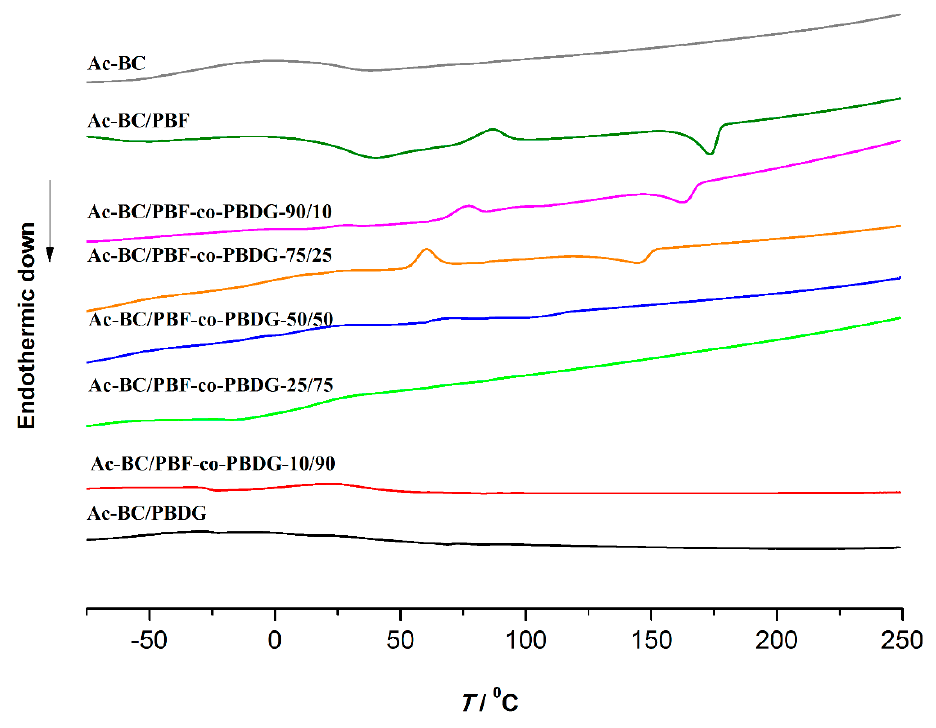
Figure 5. DSC traces of the nanocomposites and Ac-BC.